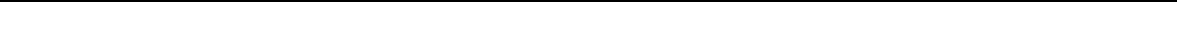
Supplementary Fig. 3: E.A.W. and E.G. Supplementary Fig. 4: A.J.W. and J.C. Supple- mentary Fig. 5: A.J.W. and J.C. Supplementary Fig. 6: E.G., A.S., and E.A.W. Supple- mentary Fig. 7: N.J.P. and E.A.W. Supplementary Fig. 8: E.K.M.J., E.G., N.J.P., and P.B. Supplementary Fig. 9: E.A.W., A.S., E.G., A.S.B., and W.J.T. Supplementary Fig. 10: E.G. and P.B. Supplementary Table 1: A.R. and J.P. Supplementary Table 2: A.S. Supple- mentary Data 1: M.R., W.B., and A.R. Supplementary Data 2: A.J.W., J.C., B.L., and J.K. Supplementary Data 3: E.C., B.L., and M.J. Supplementary Data 4: A.J.W., J.K., and B.L. Supplementary Data 5: R.R. Supplementary Data 6: A.S. Visualization: E.A.W., E.G., M. R., and I.K. Supervision: P.B. Funding Acquisition for this project: P.B. Public data analysis and interpretation: P.K., A.J.W., and P.B. Project administration: